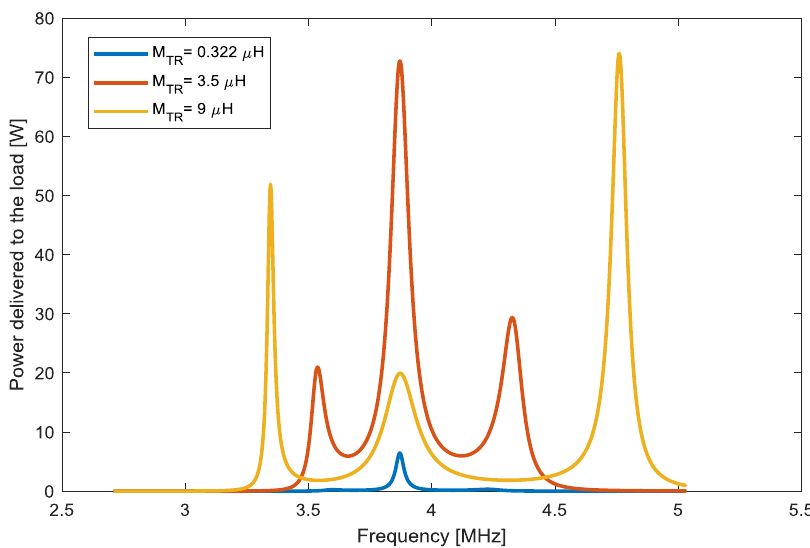
Figure 6. Power delivered to the load versus frequency for a range of frequencies.